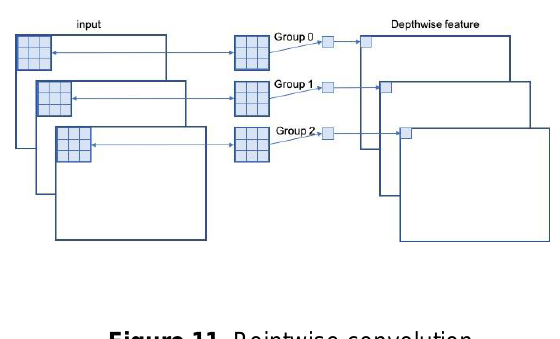
Figure 11. Pointwise